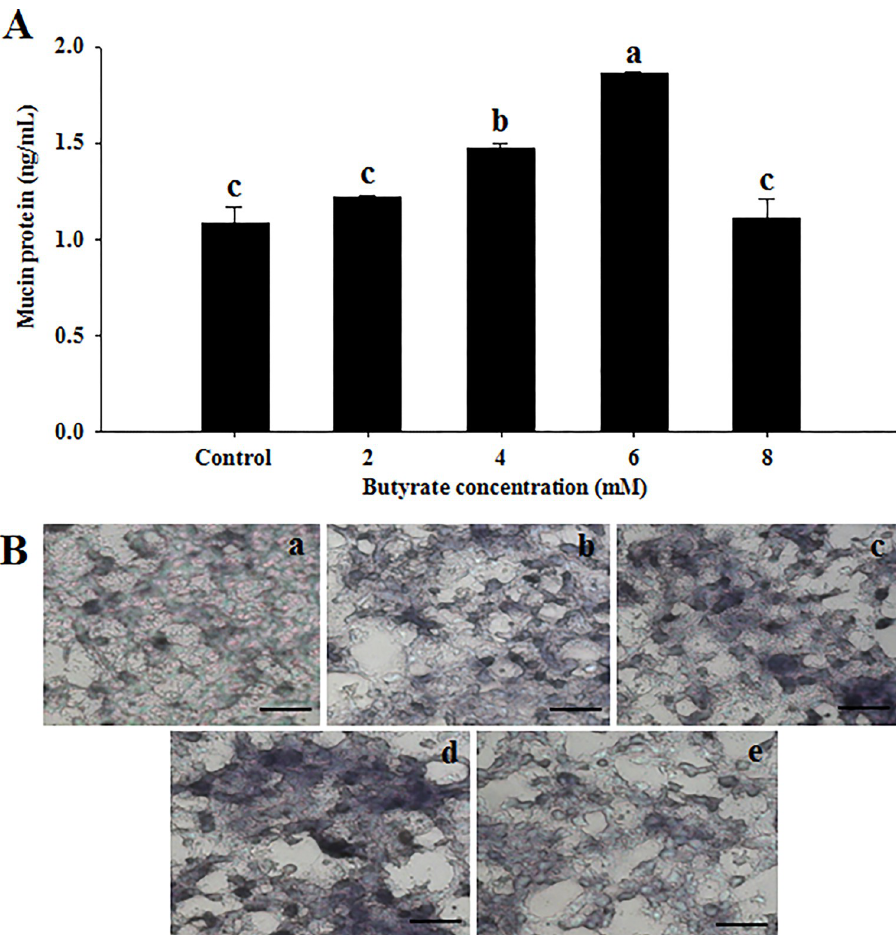
Fig 2. Effect of butyrate treatment on mucin protein production in LoVo cells. (A) Mucin protein content. Values are expressed as mean ± SEM. abc Groups with different letters in same row are significantly different by one way ANOVA-test with Duncan’s multiple range test ( p < 0.05). (B) Immunohistochemical staining of LoVo cells treated with butyrate at final concentration of 0 (a), 2 (b), 4 (c), 6 (d), and 8 mM (e). Scale bar, 100 μ m ( × 200).